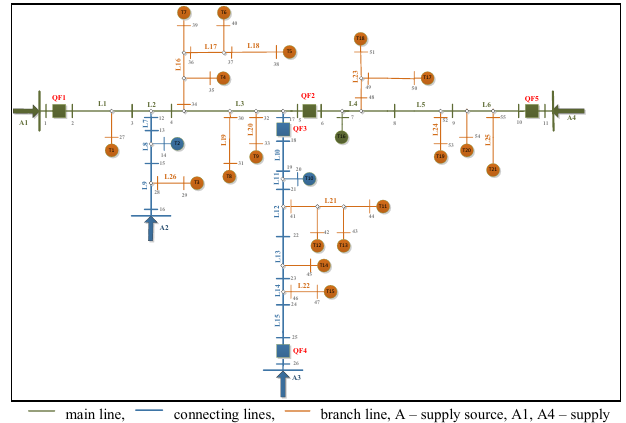
Fig. 3. Model of distribution system.